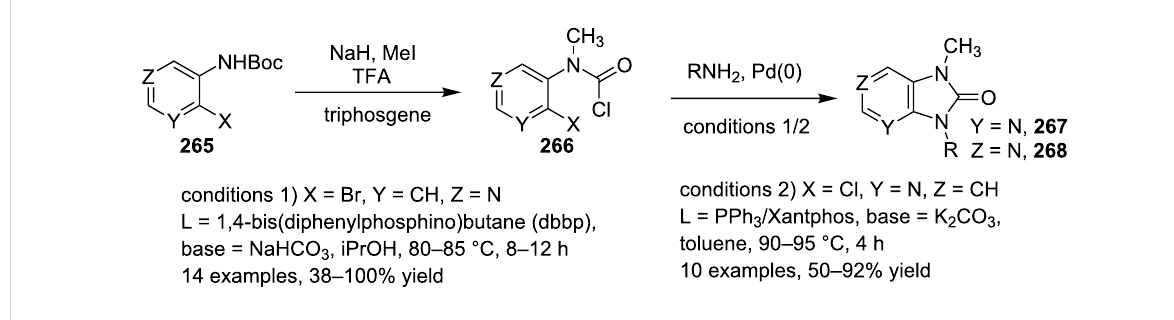
Scheme 88: Urea cyclization reaction for the synthesis of two series of pyridines.